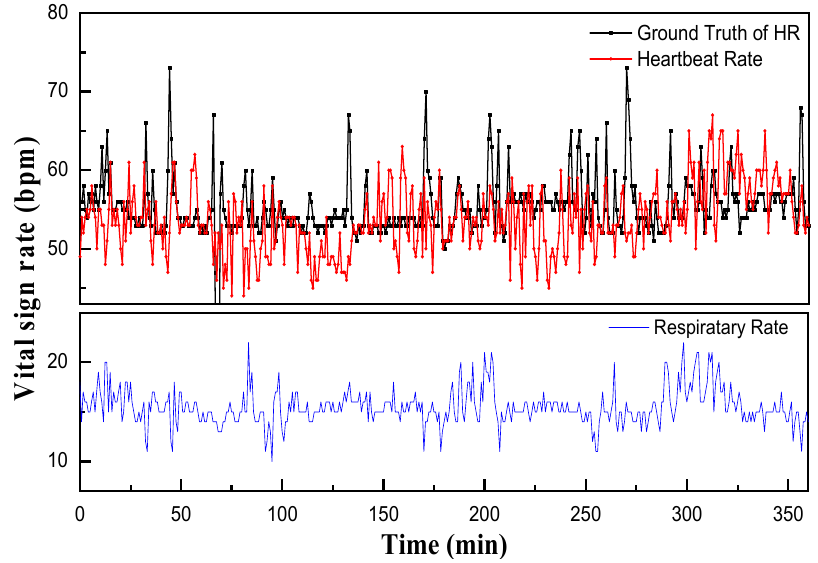
Figure 9. HR results in sleep state for about 6 h. The above panel depicts the HR and the true value results of HR, while the bottom panel depicts the respiration detection results.